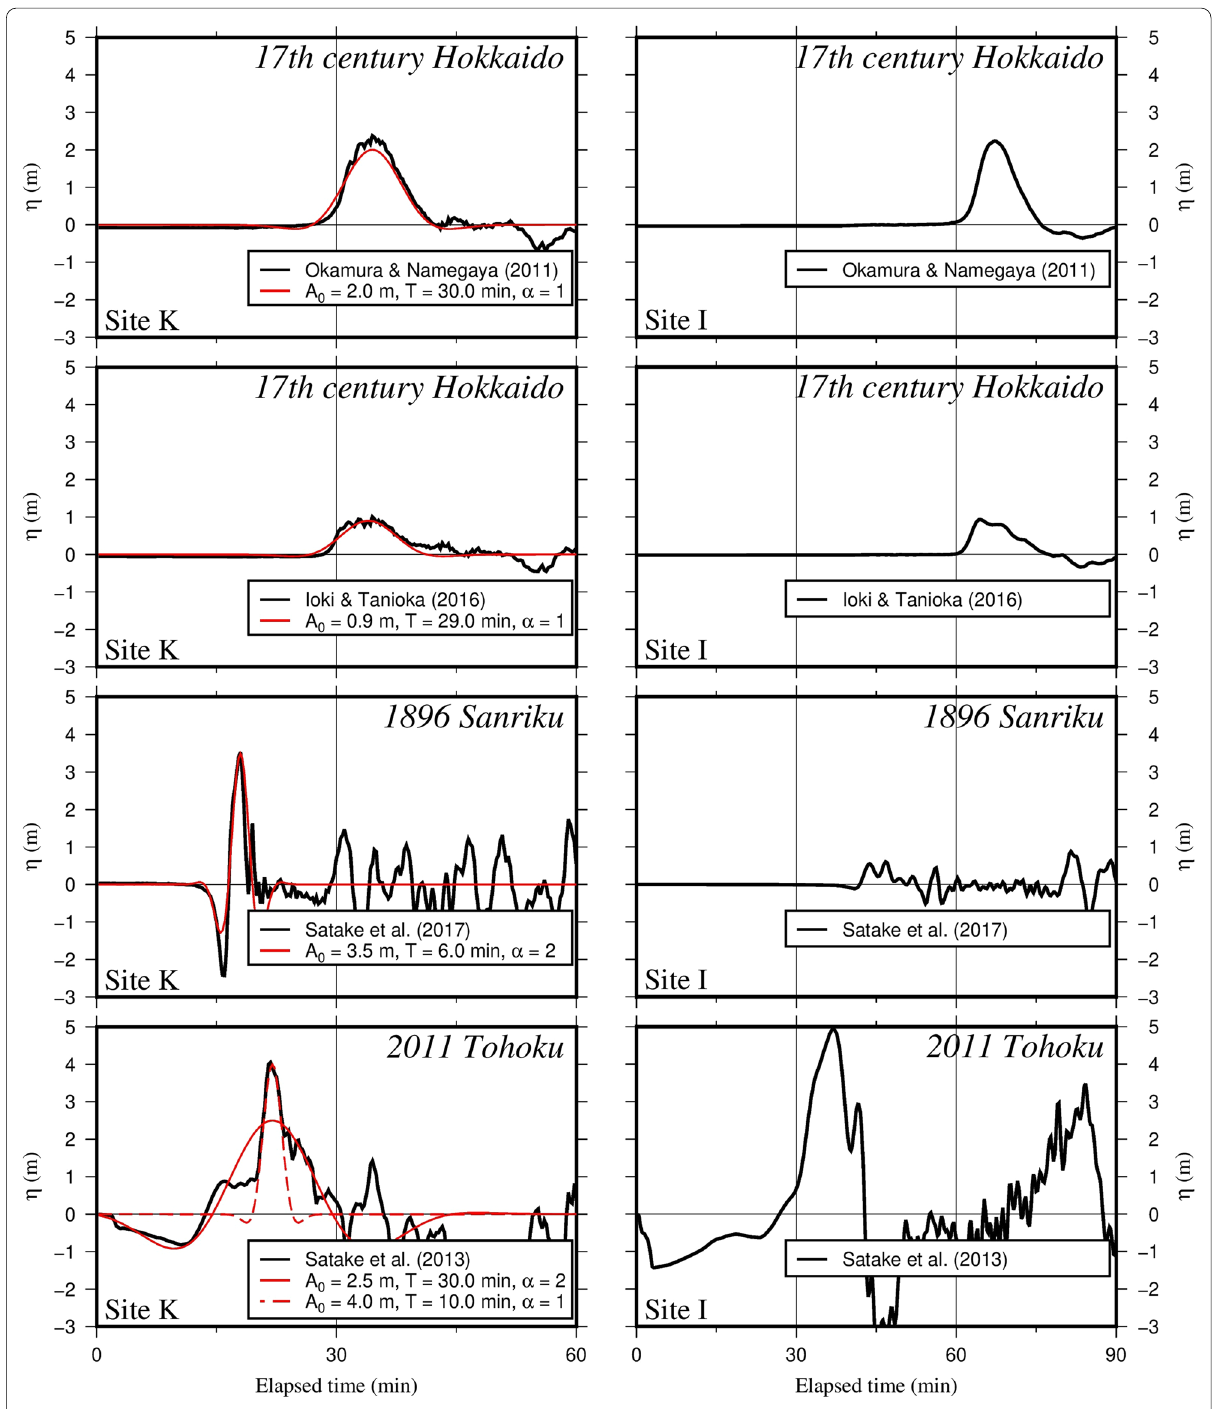
Fig. 4 Simulated waveforms at site K (left) and site I (right). These are the waveforms under the four earthquake source scenarios indicated in Fig. 1. Red lines are the waveforms that we parameterized using Eq. (1) for the simulated